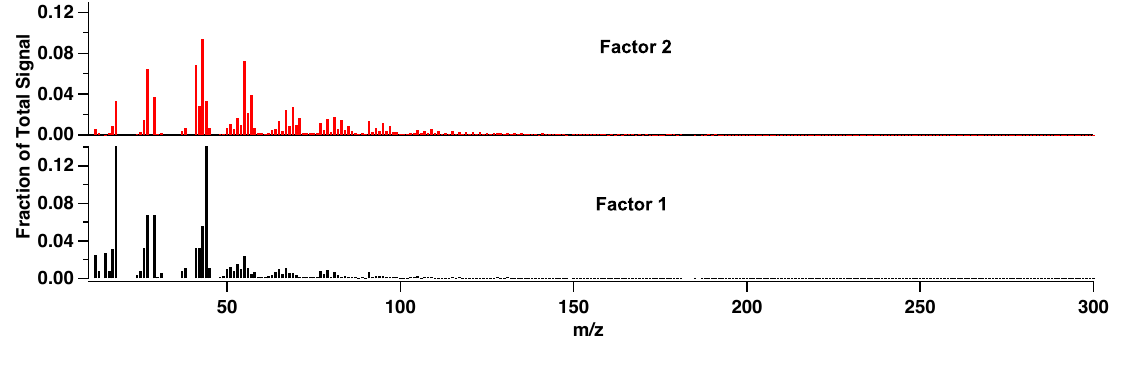
Fig. A5a. Mass spectral profiles for the 2 factor solution.